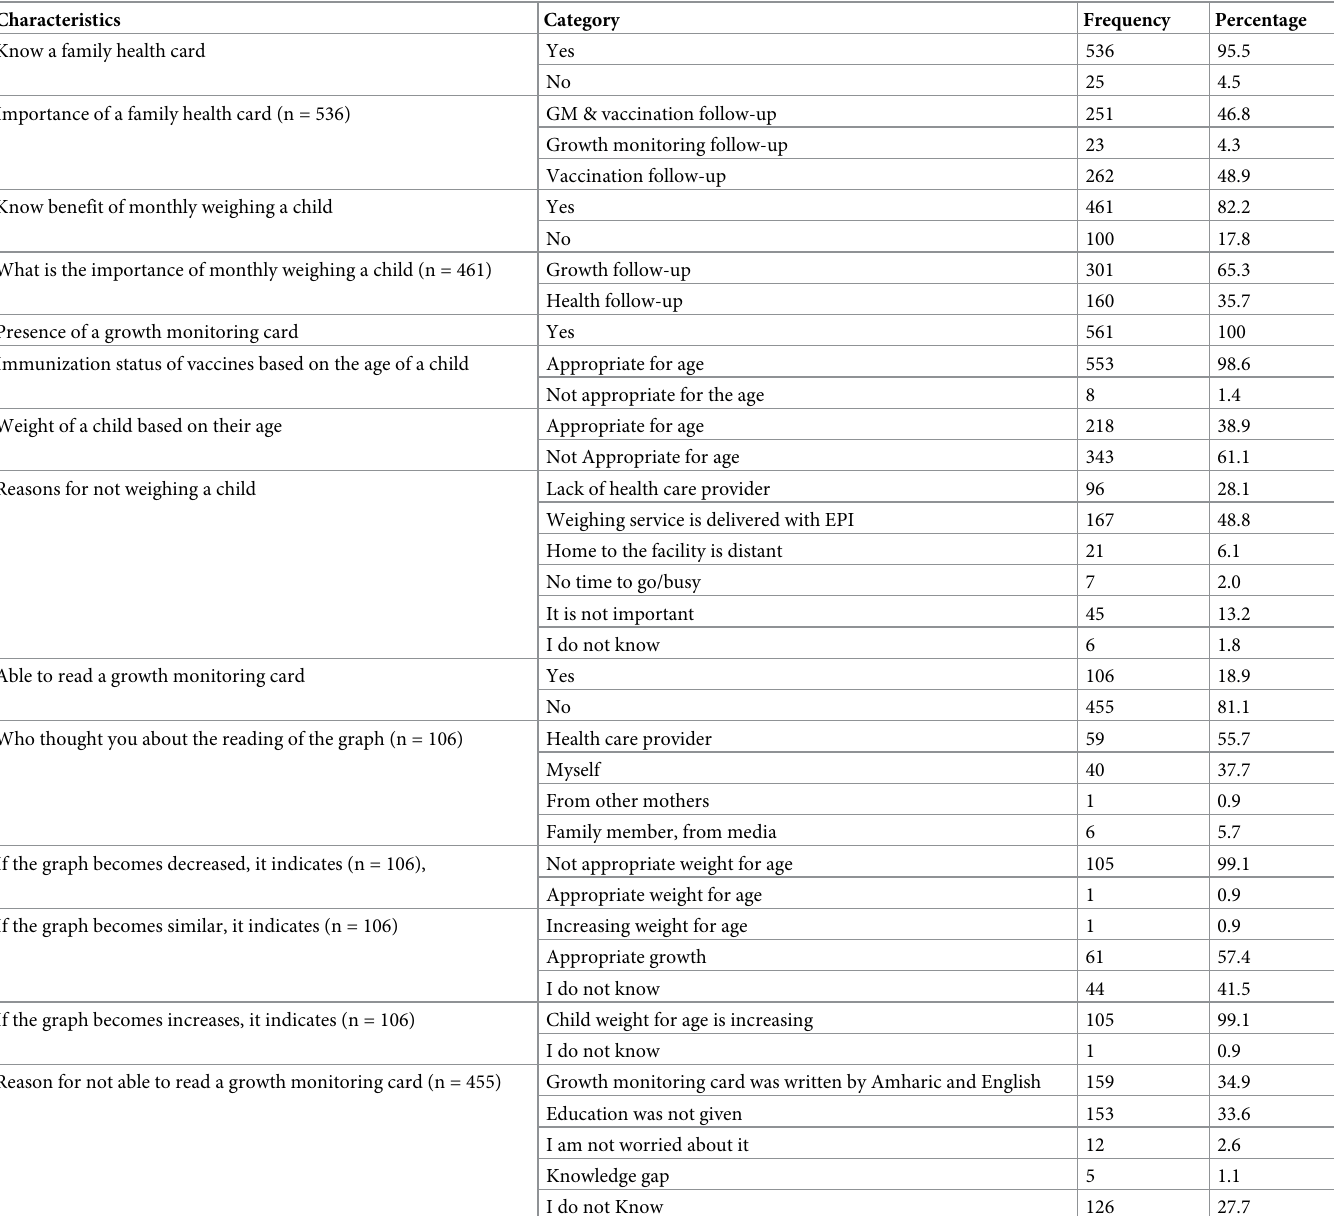
Table 4. Knowledge of growth monitoring among mothers/caregivers of 0-23-month-old children in Banja District, Northwest Ethiopia, 2020 (n = 561).